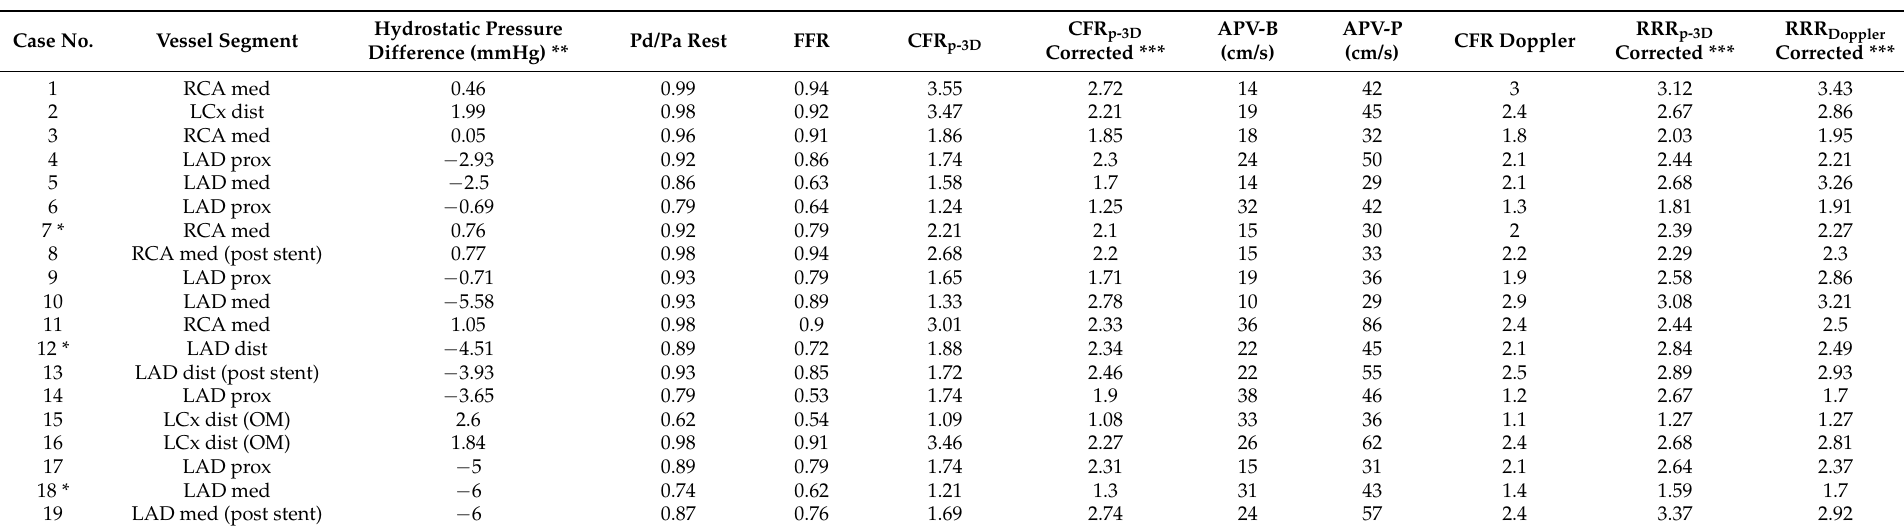
Table 2. Measured and calculated hemodynamic parameters of the interrogated